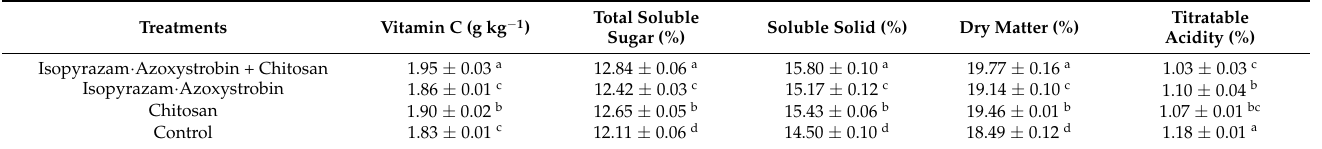
Table 4. The effects of isopyrazam · azoxystrobin and chitosan on quality of kiwifruit fruits.